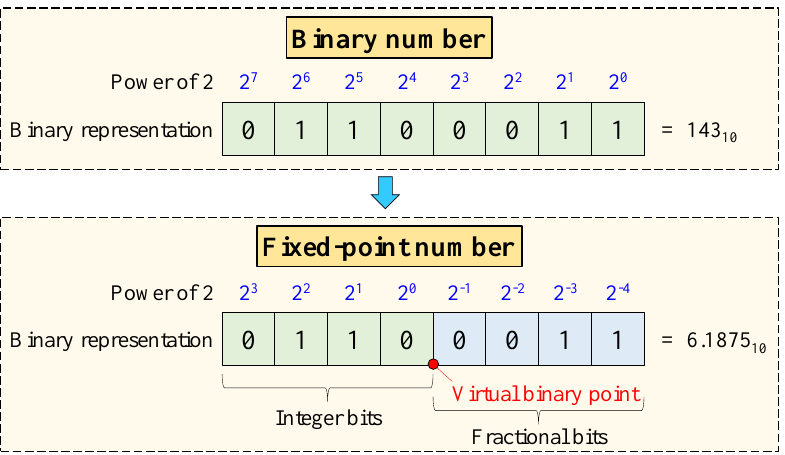
Figure 5. Example of fixed-point number